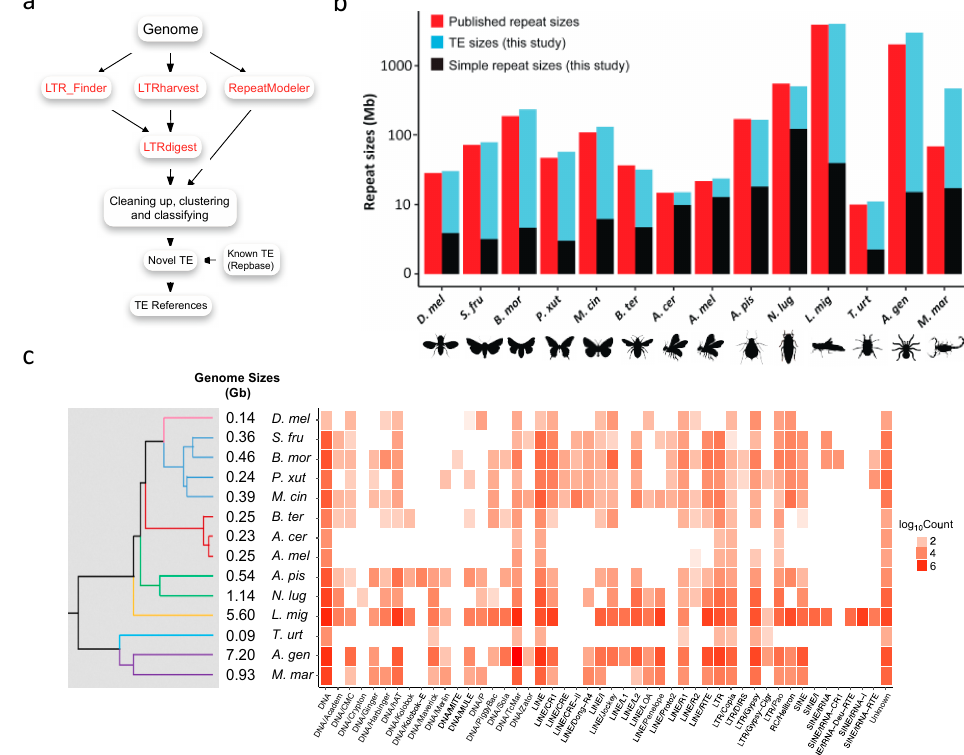
Figure 1. Annotating TEs in arthropods. ( a ) The TE reference construction workflow (see details in Materials and Methods). ( b ) The repeat sizes of fourteen arthropods. Published repeat sizes were adapted from the original genome sequencing studies (Table S1). The repeat sizes (TE and simple repeat) of this study were evaluated using the TE libraries defined in this study. The published repeat size of B. mor was adapted from [11]. D. mel , Drosophila melanogaster ; B. mor , Bombyx mori ; M. cin ,